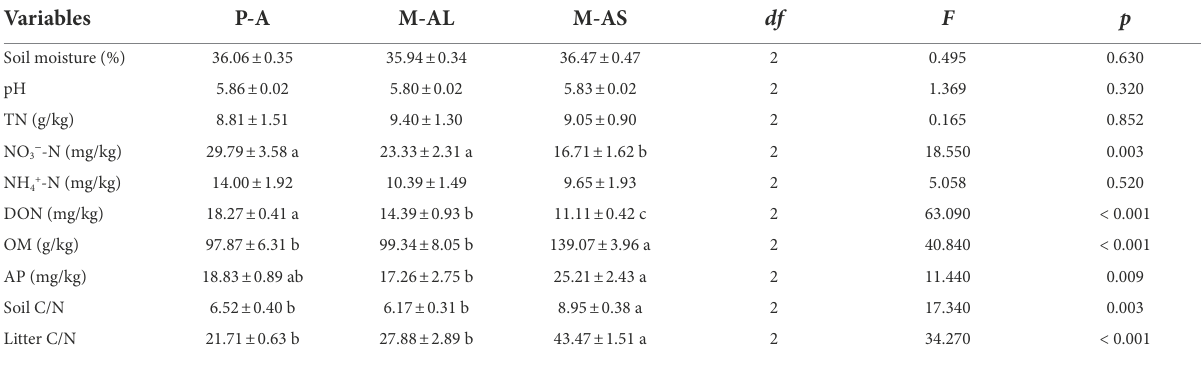
TABLE 2 Soil physicochemical properties and litter quality of ash monoculture, Ash-Larch mixture and Ash-Spruce mixture stands at Maoershan Experiment Station, Northeast China.